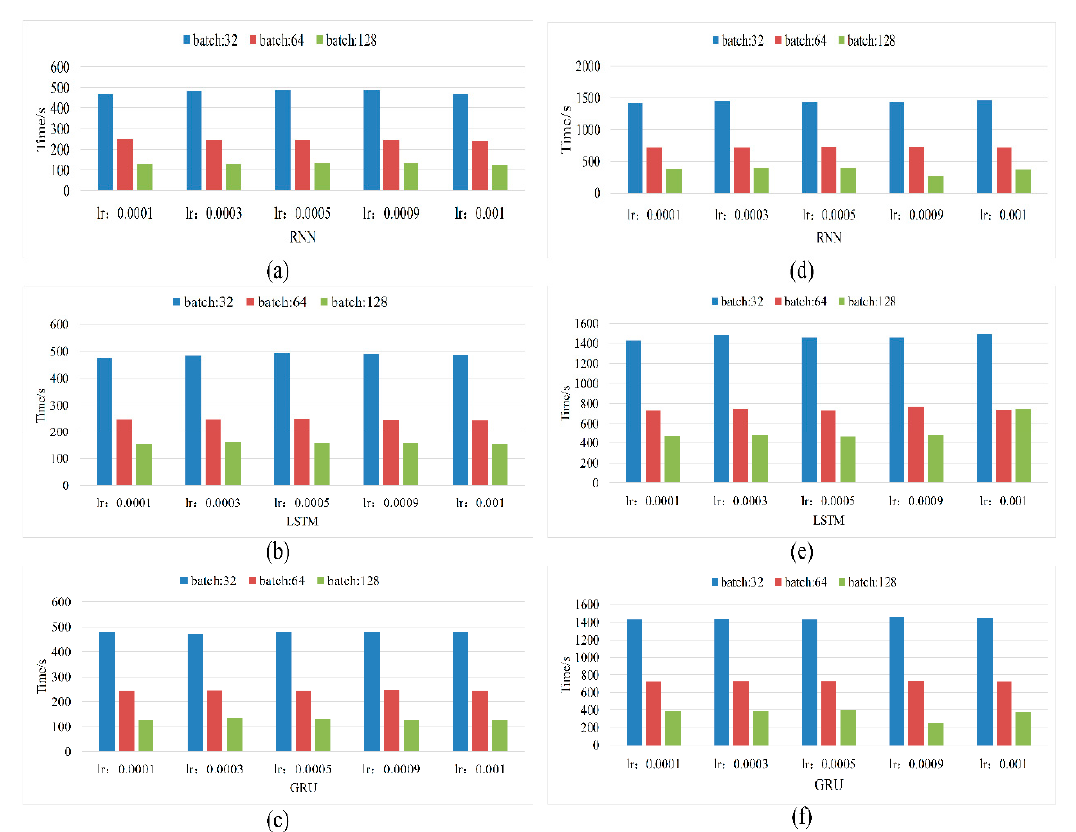
Figure 11. Comparative time consumption with the two methods. ( a , d ), ( b , e ), ( c , f ) are comparison of time consumption under the same parameter model respectively.